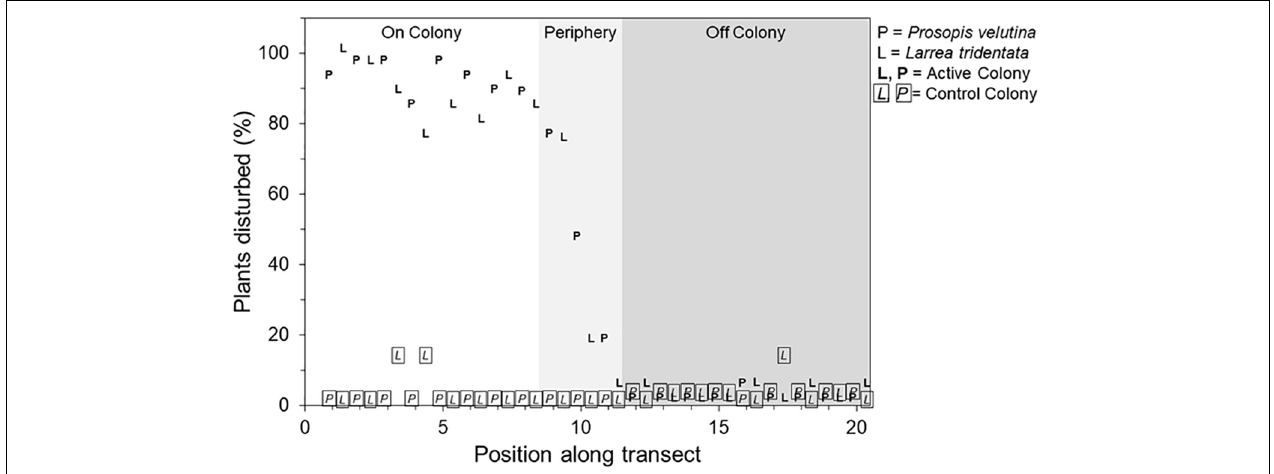
FIGURE 4 | Mean percentage of simulated Prosopis velutina (denoted “P”) and Larrea tridentata “saplings” (denoted “L”) disturbed along transects originating at the centers (position = 0) of active black-tailed prairie dog ( Cynomys ludovicianus ) colonies (bold font) and a control colony (italic font, boxed). Transects varied in length, depending upon the size of the colony, so positions are relativized such that 1–8 represent locations on colony, 9–11 represent locations on the colony periphery, and 12–20 denote the off colony locations (see Supplementary Figure S1